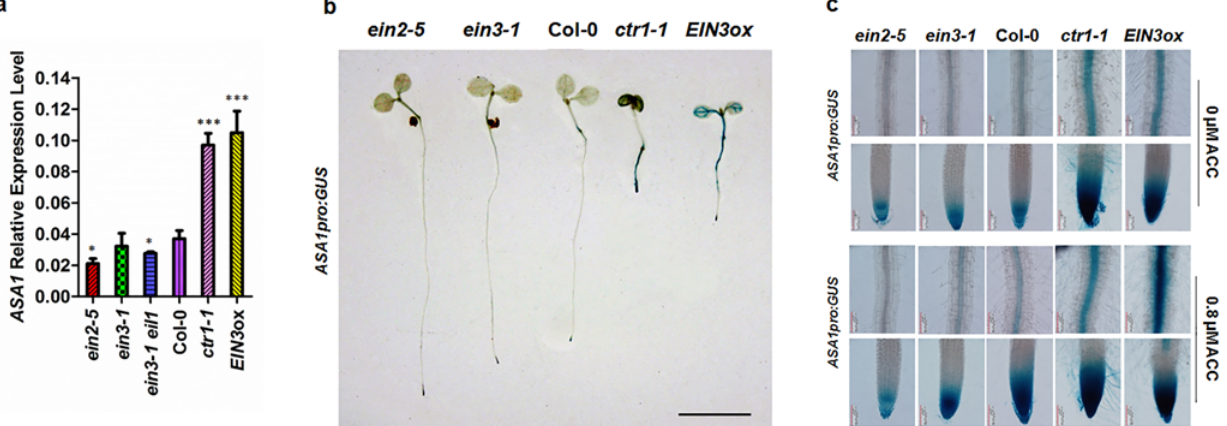
Fig 7. The expression of ASA1 was regulated by ethylene signal pathway. ( a ) The expression of ASA1 in ethylene signal pathway mutants. Ethylene signal pathway-related mutants ein2-5 , ein3-1 , ein3-1eil1 , ctr1-1 , and Col-0 were grown on MS medium for 5 d while the seeds of EIN3-FLAG ( iE / qm ) ( EIN3ox ) were grown on MS medium supplementing with 1 μ M β -estradiol for 5 d. Total RNA was extracted from roots. The expression level of ASA1 was checked by qRT-PCR. Values are mean ± SD of three replicas ( * P < 0.05, ** P < 0.01, *** P < 0.001. Asterisks indicate Student ’ s t-test significant differences). ( b ) ASA1 pro : GUS expression in 5-day-old seedlings. Three independent experiments were performed with each replica containing 15 plants for each line. Representative seedlings were photographed. Scale bar, 0.5 cm. ( c ) ASA1 pro : GUS expression in primary root maturation region and root tip of 5-day-old seedlings without or with ACC treatment. More than 20 plants were observed for each genotype. Representative photos were